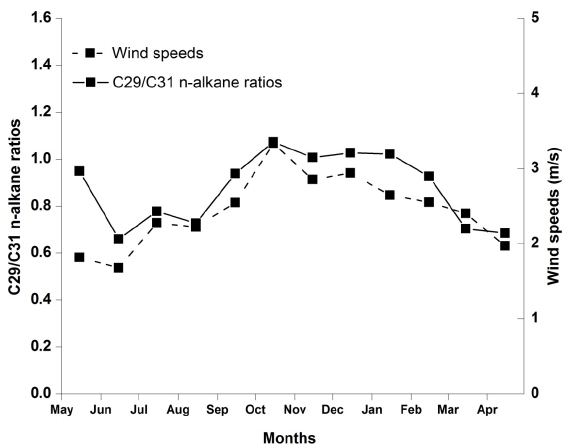
Figure 7. Temporal variations in C 29 /C 31 n -alkane ratios of air ambient aerosols (the solid line) and monthly average wind speeds (the dash line) in south coastal Xiamen.